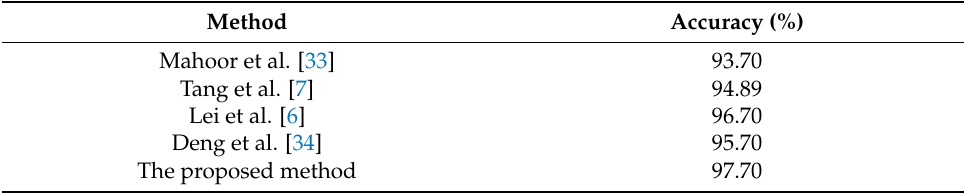
Table 4. Classification accuracy of different